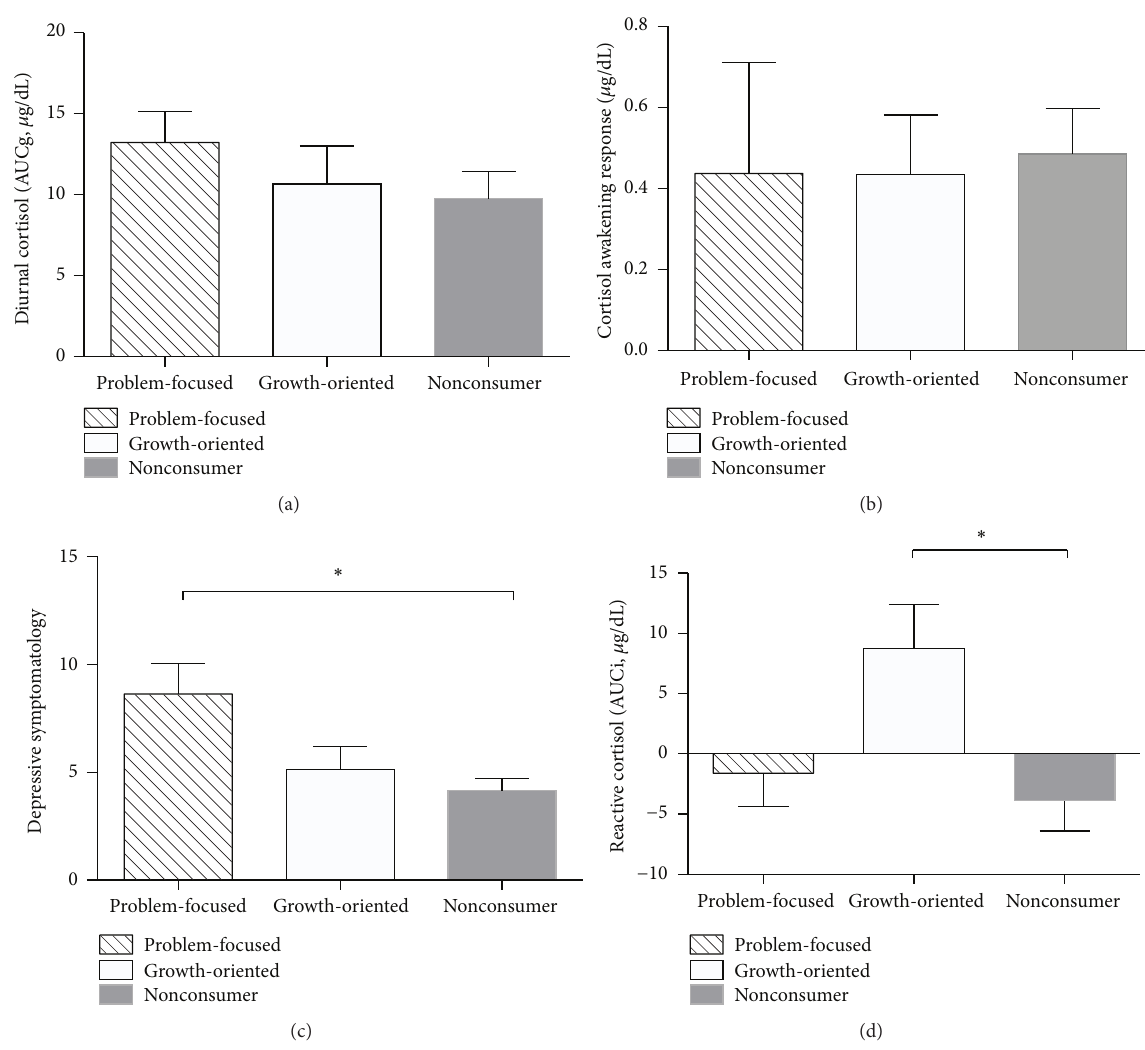
Figure 3: (a) Diurnal salivary cortisol levels (AUCg) as a function of group. (b) Cortisol awakening response as a function of group. (c) Reactive salivary cortisol levels (AUCi) in response to the Trier Social Stress Test as a function of group. (d) Depressive symptomatology as a function of group. The asterisk ( ∗ ) means 𝑃 < 0.05 . For each figure, the error bars represent the standard error of the mean adjusted for age and body mass